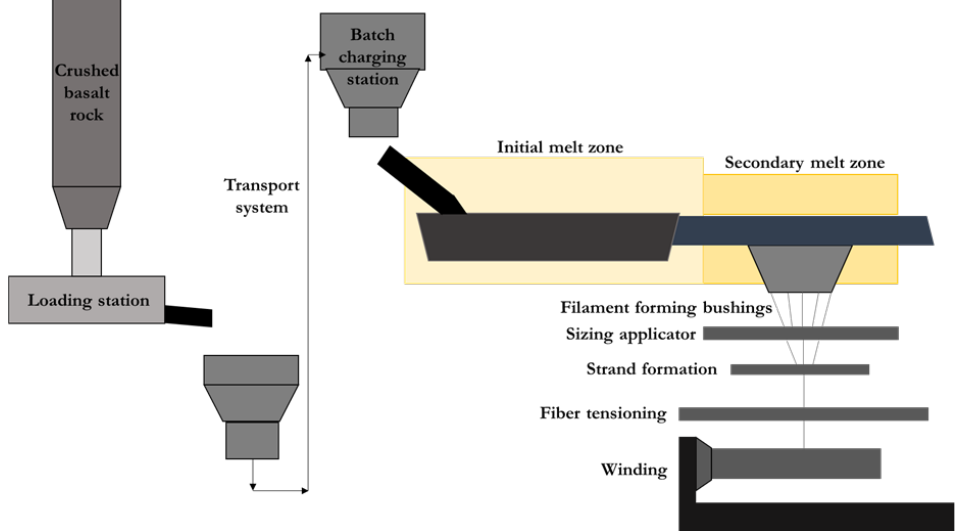
Figure 1. Schematic of Spinneret technology (redrawn from [7]).